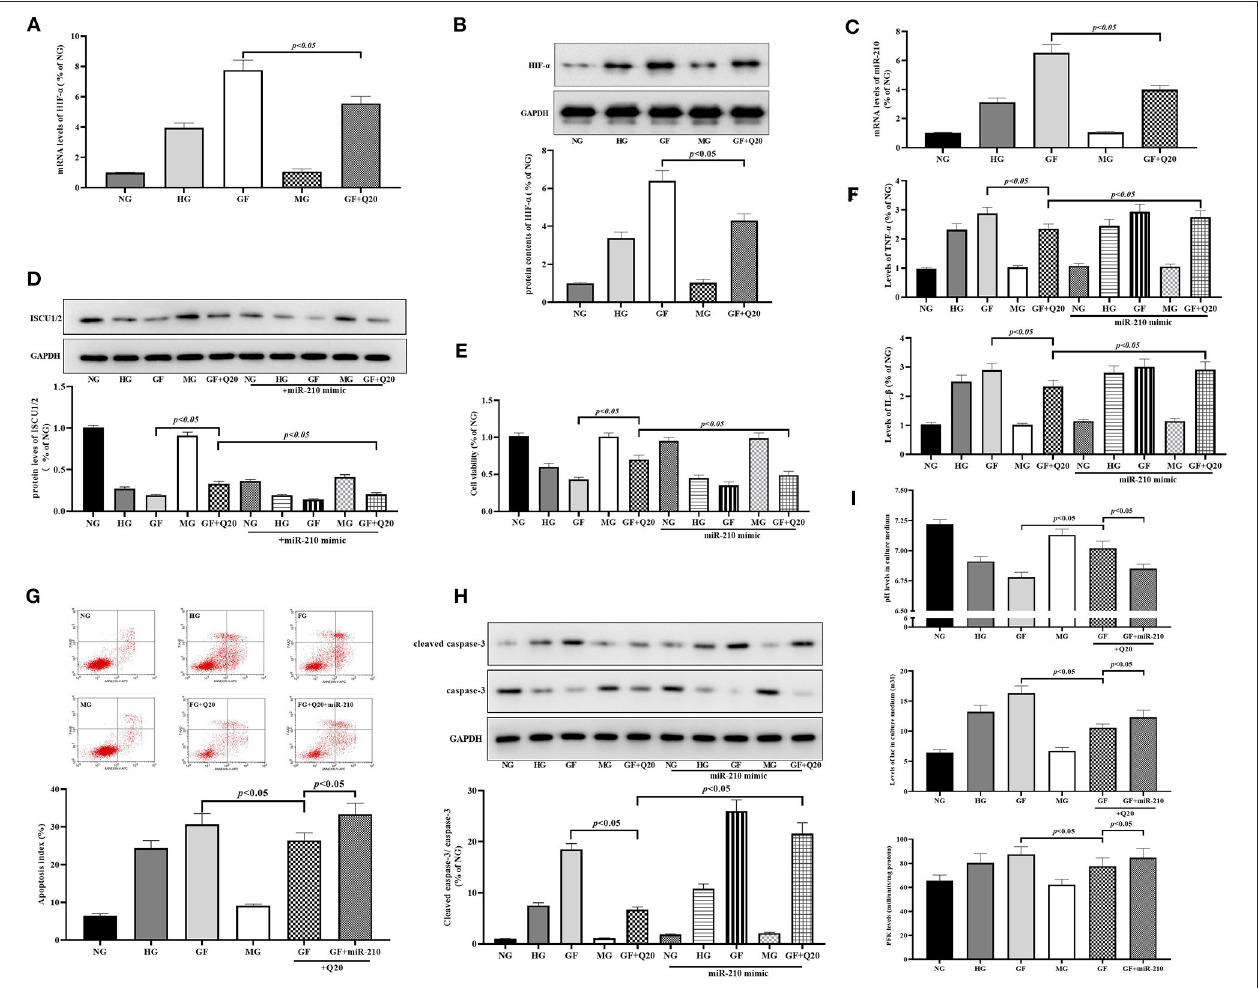
FIGURE 5 | Quercetin inhibited GF-induced upregulation of HIF-1 α /miR-210 levels. (A,B) mRNA expression and protein contents of HIF-1 α measured by RT-qPCR and WB, respectively. (C) RT-qPCR analysis presented expression of miR-210. (D) Western blot analysis showing levels of ISCU1/2. (E) Cell viability tested by CCK8. (F) Levels of inflammation factors. (G,H) The effects of quercetin and miR-210 mimic on index of apoptosis and activity of caspase-3 in MCs. (I) Effects of quercetin and miR-210 mimic on aerobic glycolysis activity (levels of pH, lac, and PFK). The error bar reflects the S.E.M. of at least three independent